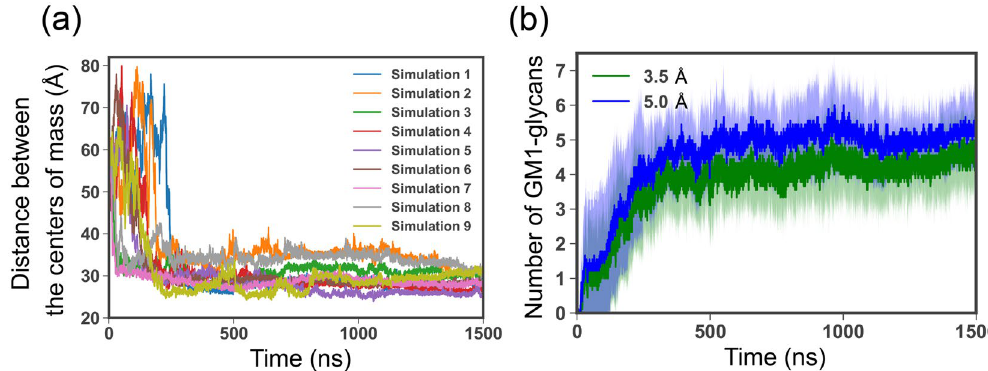
Figure 2. ( a ) Time series of distance between centers of mass of A β 40 and the GM1-glycan cluster in each different trajectory. ( b ) Time series of average number of GM1-glycans bound to A β 40 with different cutoff distances, 3.5 and 5.0 Å. Dark color and light color mean average value and sample standard deviation at each time, respectively.